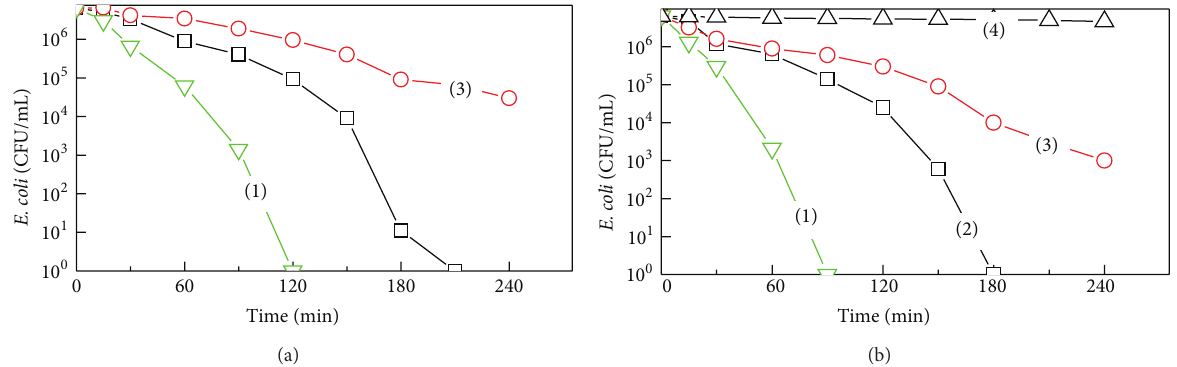
Figure 8: E. coli inactivation under solar simulated light for (1) TiO 2 /In 2 O 3 (sputtered for 10min/10s), (2) TiO 2 (sputtered for 10 min), (3) In 2 O 3 (sputtered for 10 s) samples, respectively, and (4) a bare polyester sample, at light intensities: (a) 30mW/cm 2 and (b) 50 mW/cm 2 .